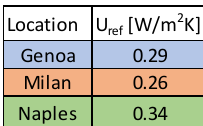
Figure 6. Thermal transmittance in brick walls with different heat reflective insulating layers. The red, blue, and green lines represent the threshold for different cities.